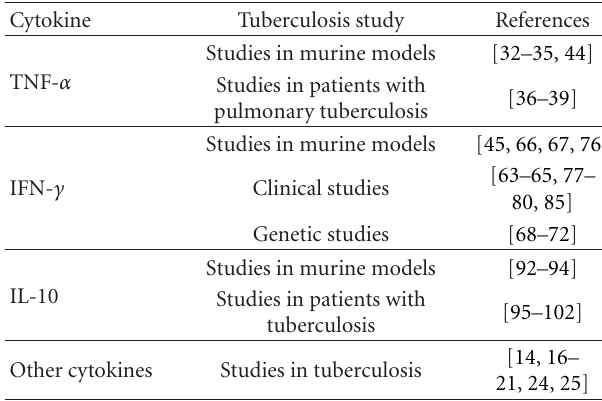
Table 1: Studies of cytokines associated to M. tuberculosis